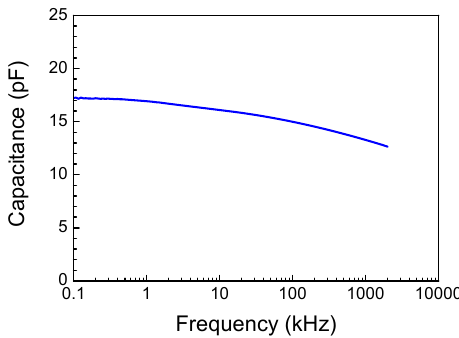
Figure 4. Room temperature C ‐ f characteristic of the sample. Figure 3. Room temperature I ‐ V characteristic of the sample.